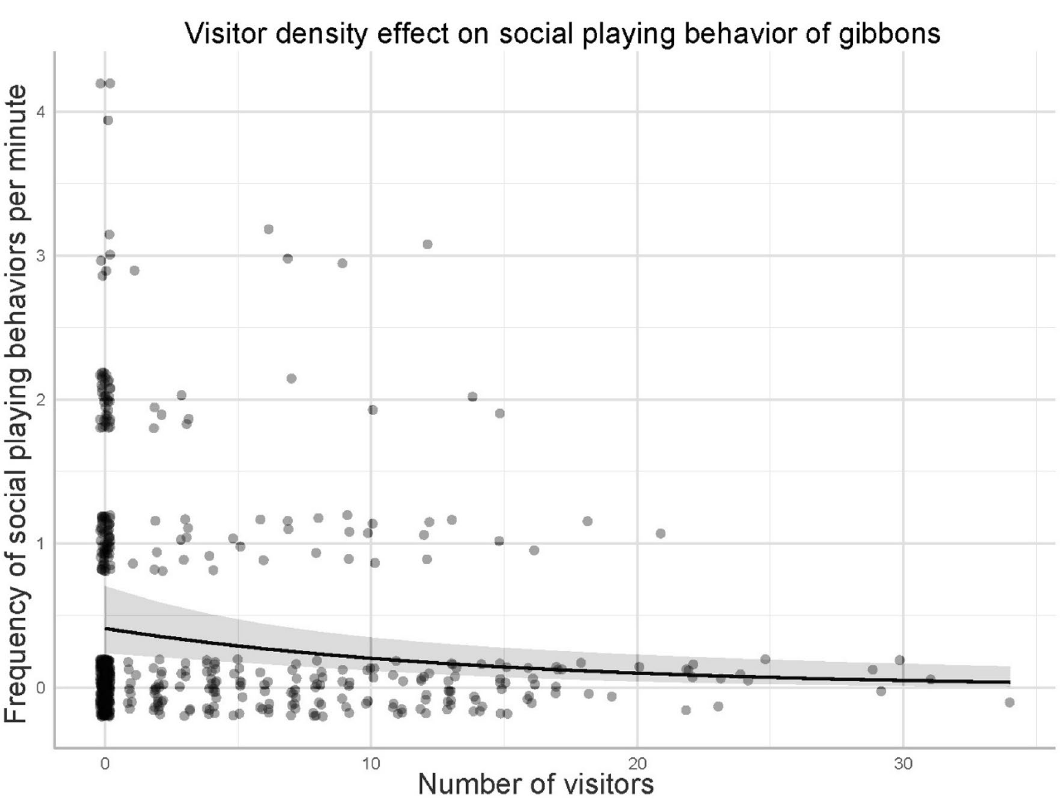
Figure 3. Effect of density effect (model 2b) on the social-playing behavior of the two gibbons ( Hylobates lar and Nomascus gabriellae ). The shaded area indicates 95% confidence interval.